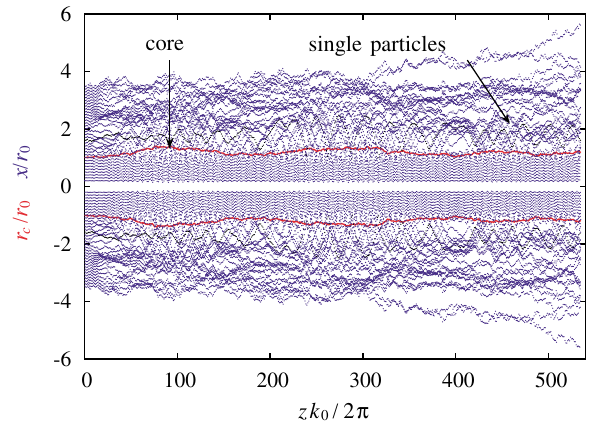
FIG. 7. (Color) Maximum amplitude growth for single par- ticles over 100 zero-current betatron periods as a function of their initial radius and of the rms error amplitude. Each dot represents the averaged results of 1000 runs with different error sets for a tune depression of (cid:18) (cid:3) 0 : 8 .